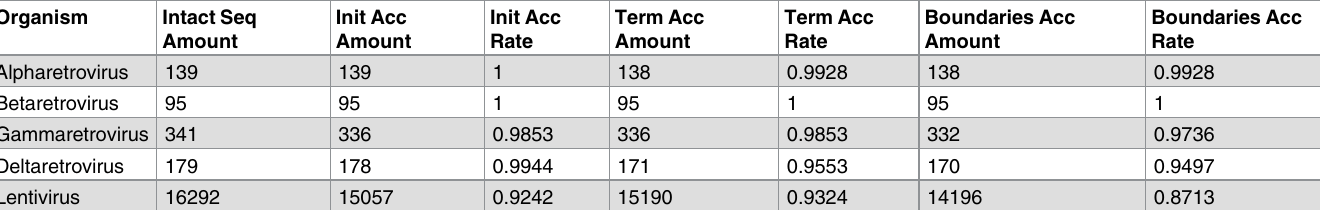
Table 4. Prediction performance on sequences with intact MAs from different retrovirus genuses.